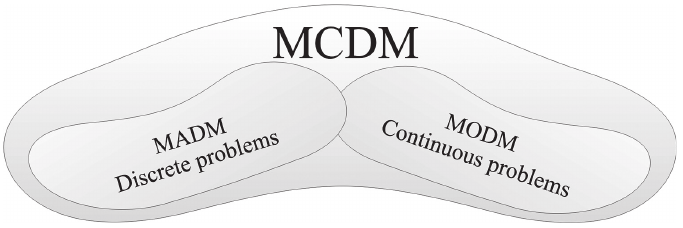
Fig. 1. Broad classification of MCDM